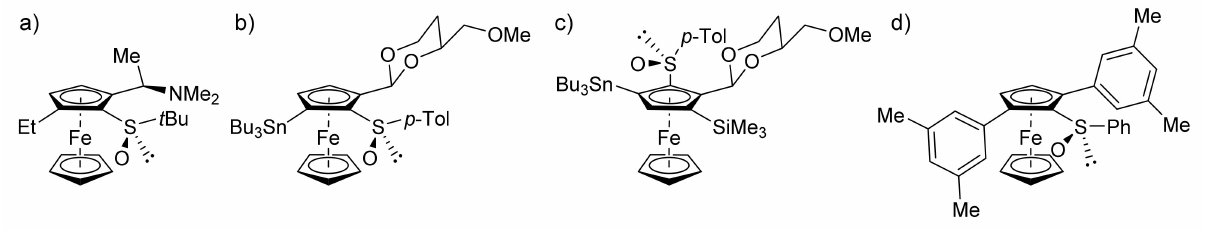
Figure 1. Polysubstituted ferrocenesulfoxides already reported by the groups of ( a ) Nicolosi, ( b , c ) Top and Jaouen, and ( d )